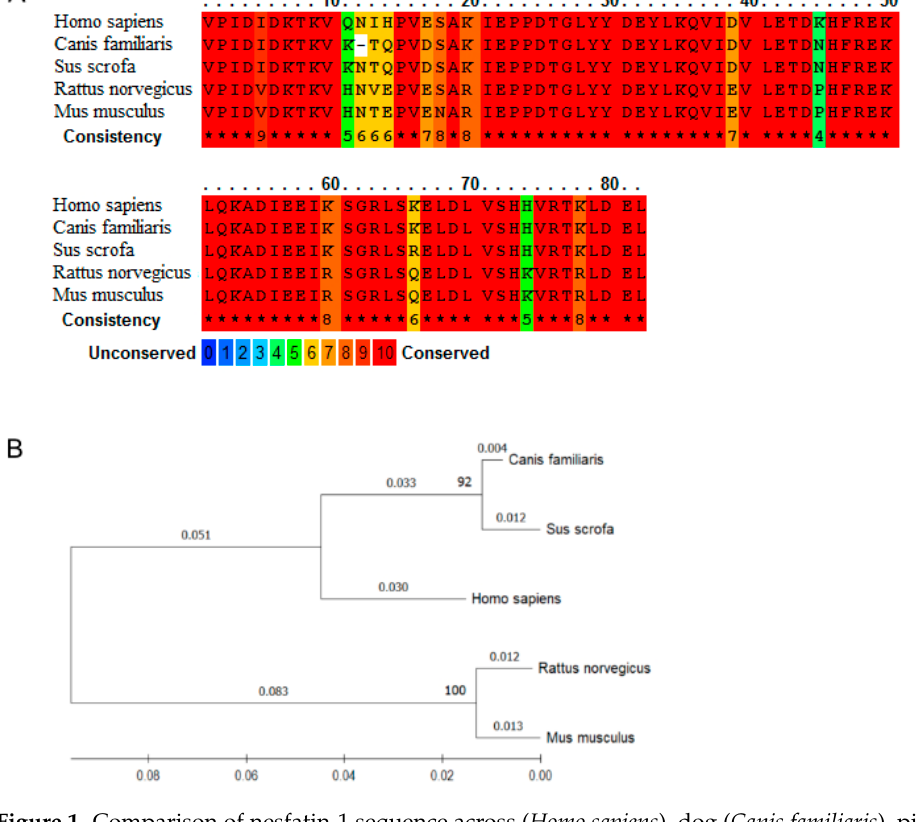
Figure 1. Comparison of nesfatin-1 sequence across ( Homo sapiens ), dog ( Canis familiaris ), pig ( Sus scrofa ), rat ( Rattus norvegicus ), and mouse ( Mus musculus ) shows a high homology at the amino acid level. ( A ) Nesfatin-1 amino acid sequence in human (UniProtKB: P80303), dog (UniProtKB: P80303),